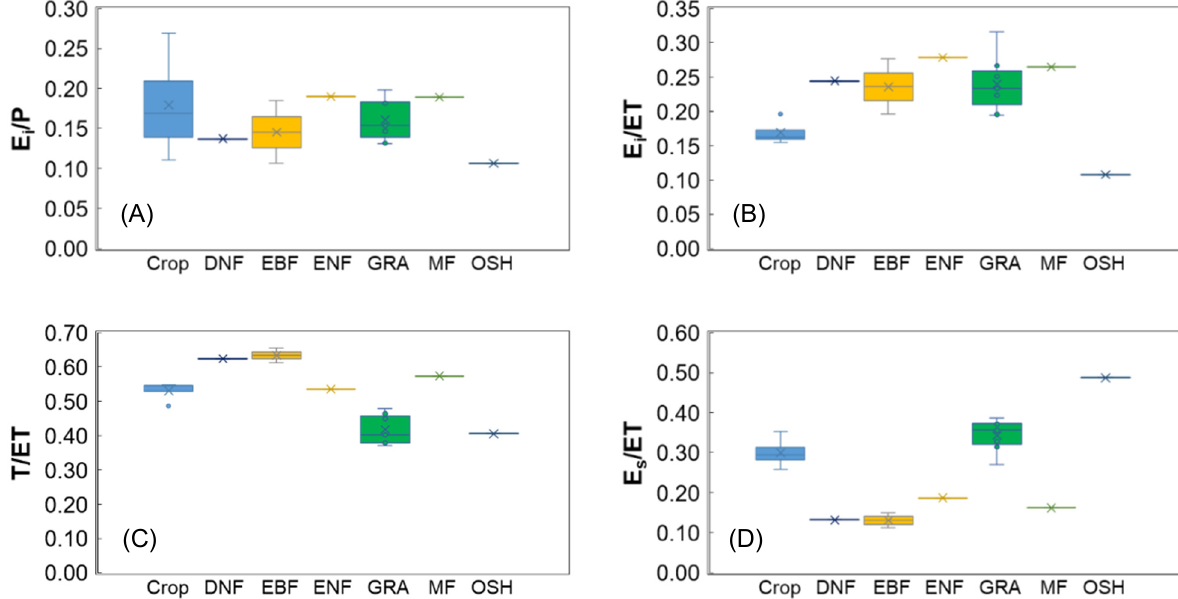
Figure 8. Ratio of ( A ) canopy interception evaporation to precipitation ( E i / P ) varies across different land covers; ( B ) canopy evaporation to total evapotranspiration ( E i / ET ); ( C ) vegetation transpiration to total evapotranspiration ( T / ET ); and ( D ) soil evaporation to total evapotranspiration ( E s / ET ). Boxes mark the 75th and 25th percentiles and the solid lines and crosses in the boxes refer to the average and median values, respectively. Table 4. Annual ratios (average) of canopy evaporation losses to the total precipitation based on land cover types.